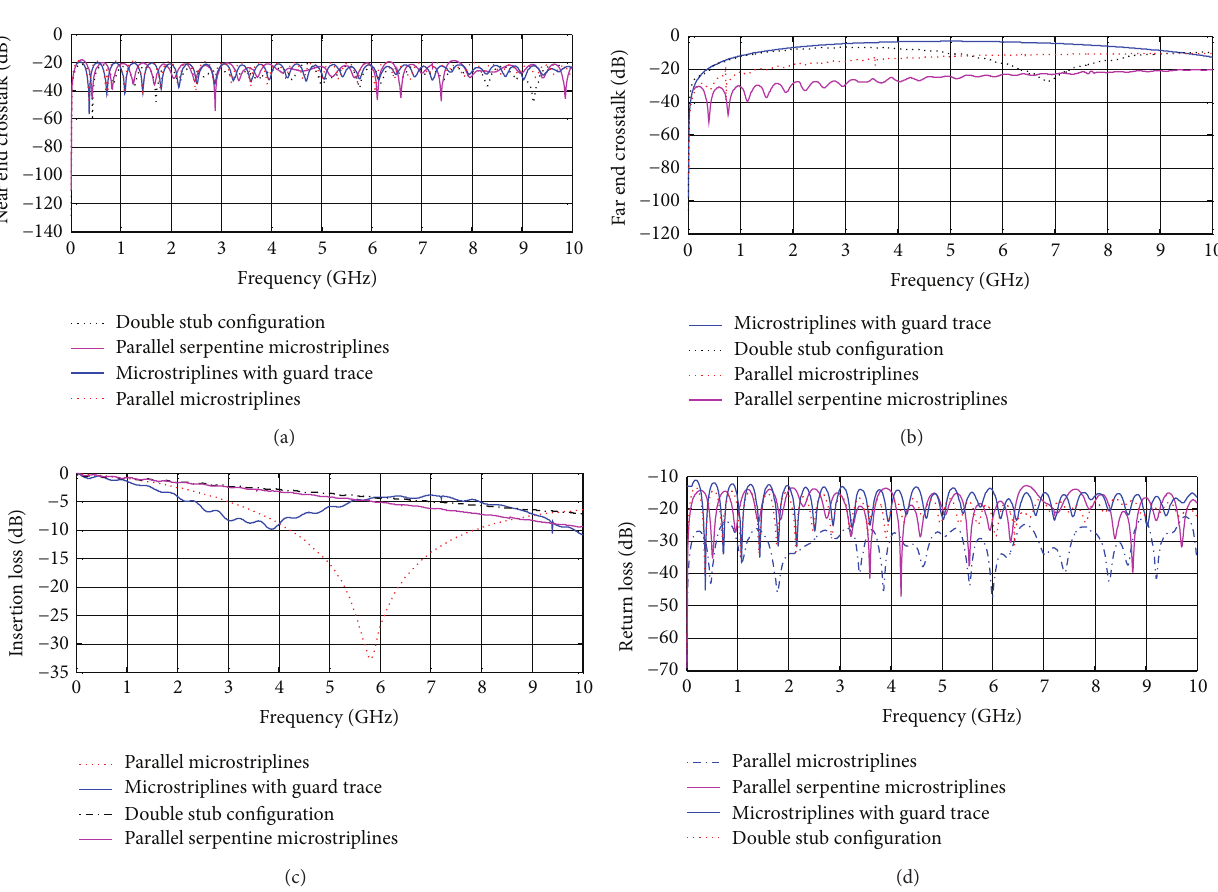
Figure 6: Numerical results for various microstripline structures for the (a) NEXT and (b) FEXT. (c) Insertion loss; (d) return loss.